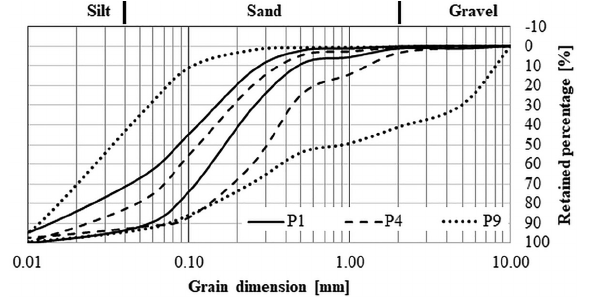
Fig. 5. Grain size analysis of bottom sediments of the Moszczenica River.